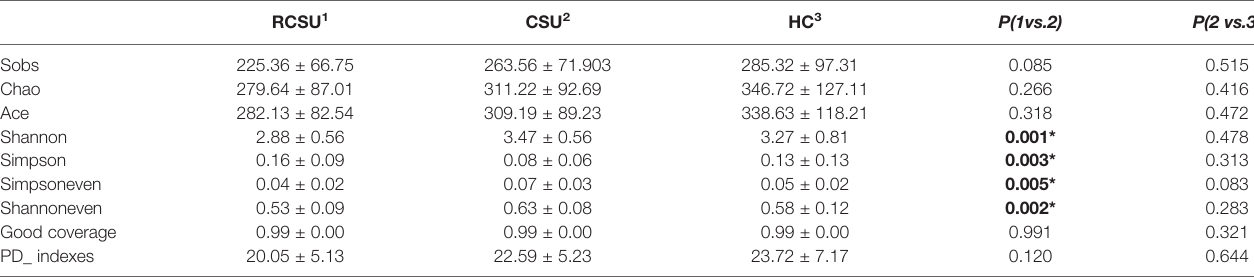
TABLE 2 | a Diversity analysis in the three groups at OTU